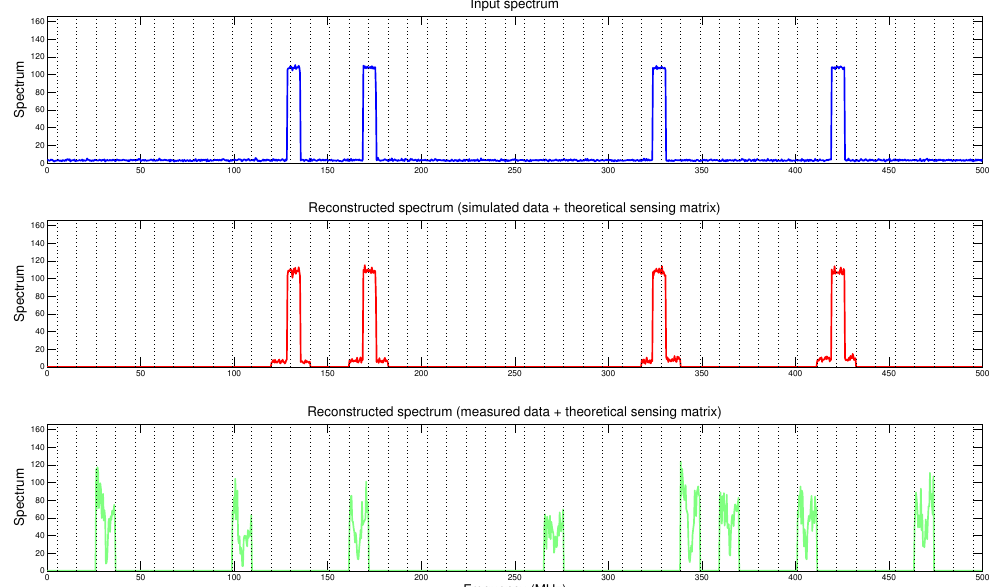
Figure 6. Comparison of reconstructed spectrum with four transmitters and SNR = 30 dB using theoretical sensing matrix (simulated data vs. measured